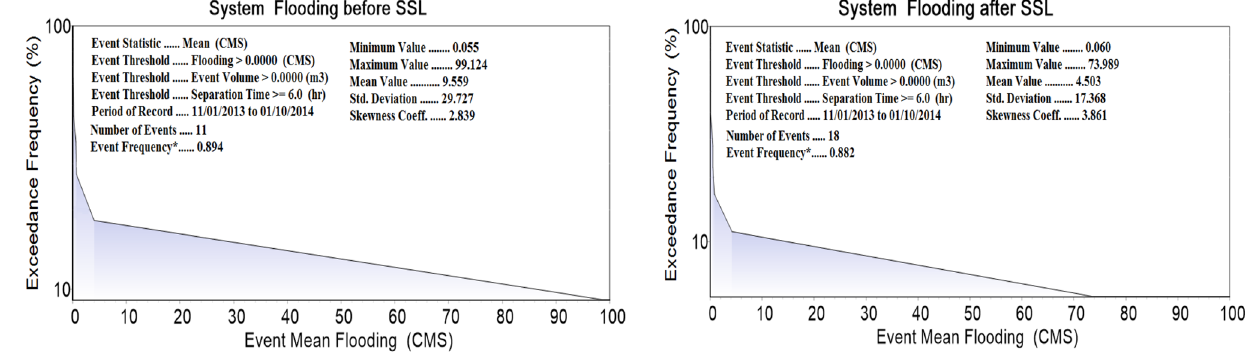
Fig. 9 Sewer system flooding before SSL (on the left) and after installed SSL (on the